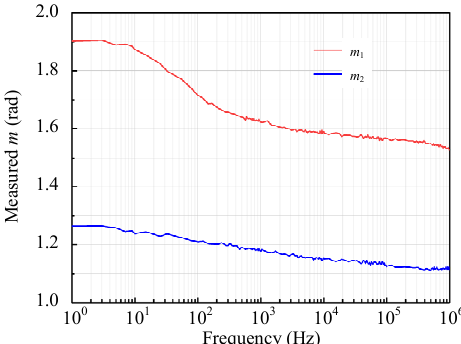
Fig. 4 Measured modulation depths of modulation and bias ports of the MZM as a function modulation frequency, where the microwave driving level is set to be 2.25 V (17.04 dBm).